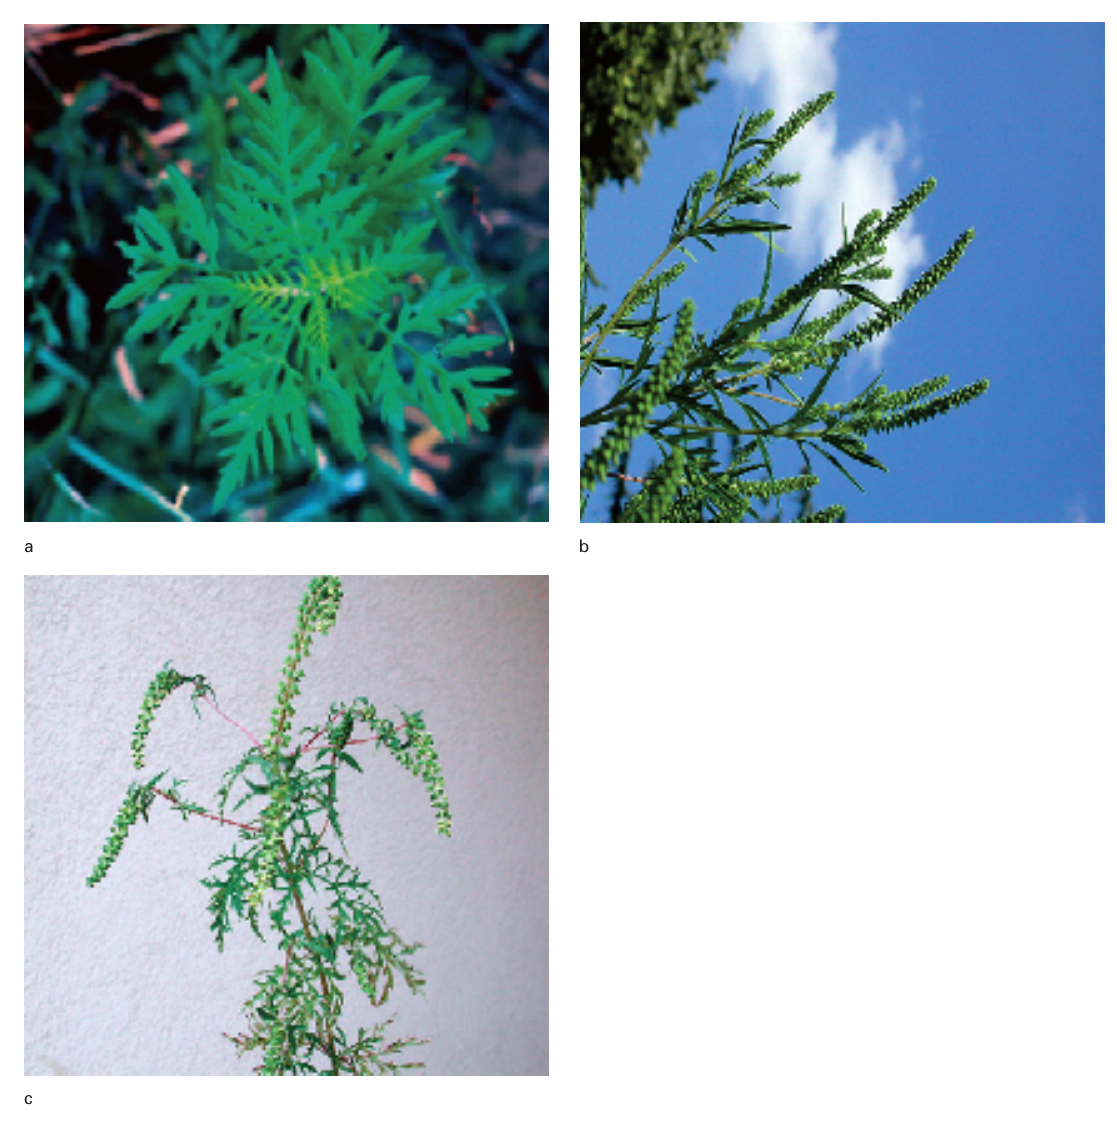
Figure 1 a. Plantlet; b. Flowers just before pollinisation; c. Ambrosia plant